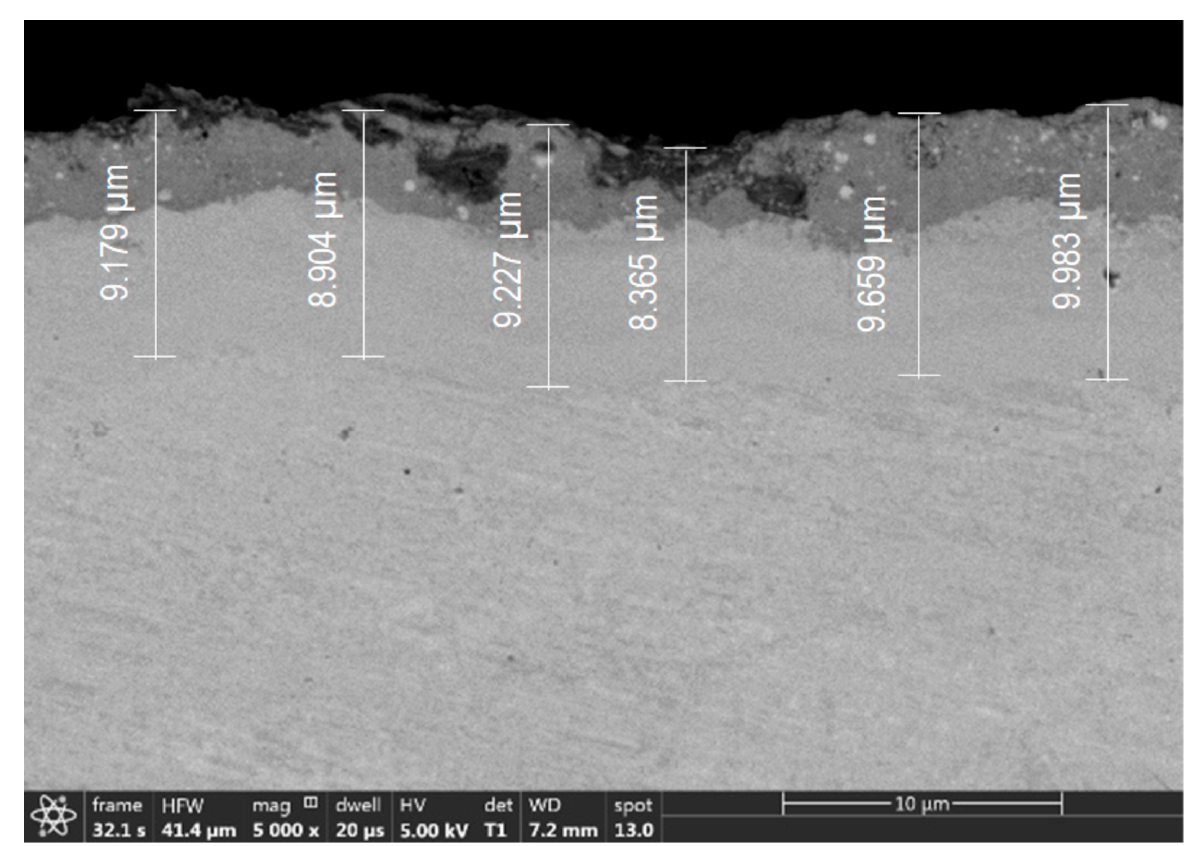
Figure 4. Cross-sectional analysis of oxy-nitrided AISI 304 SS with 20 wt% urea, viewed under the SEM at 5000× using secondary electrons.